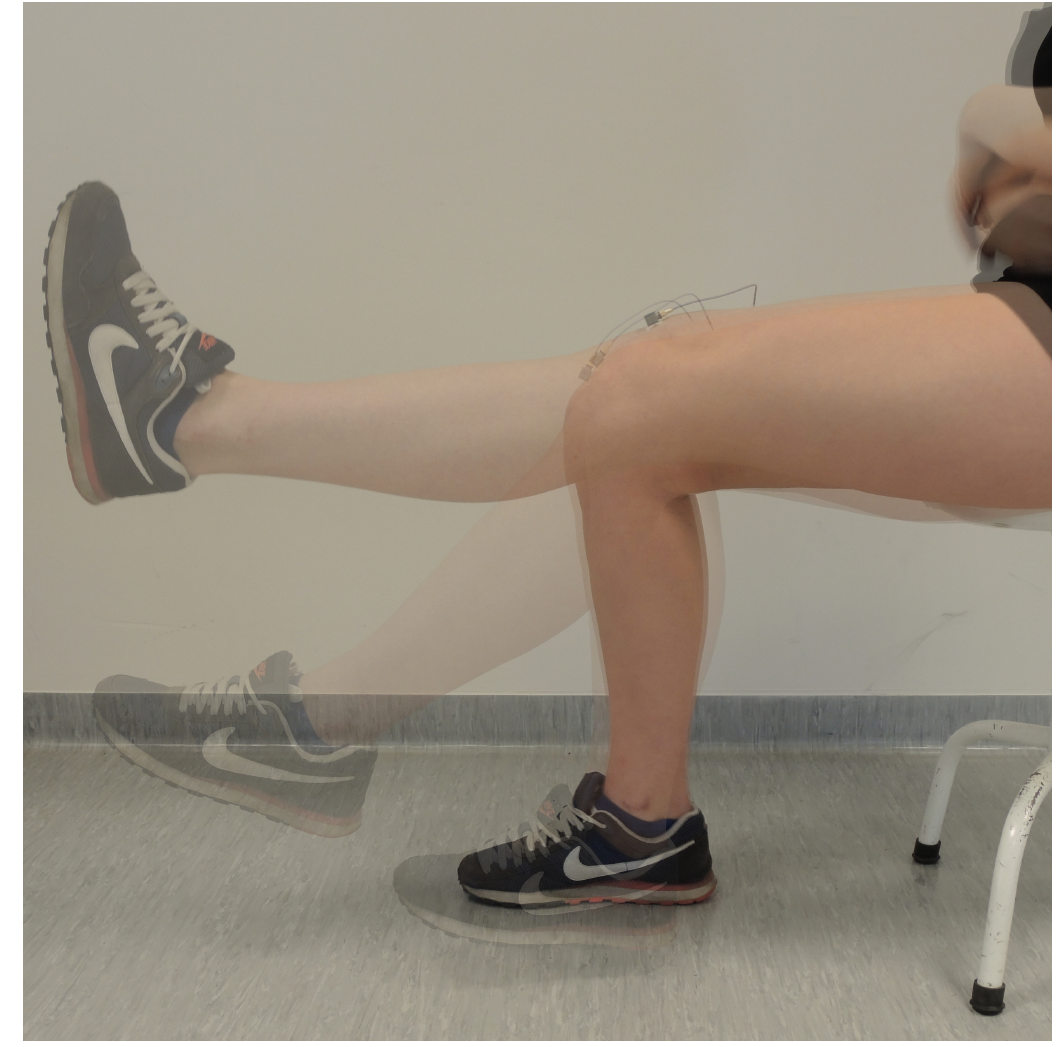
Figure 1. VAG signal’s